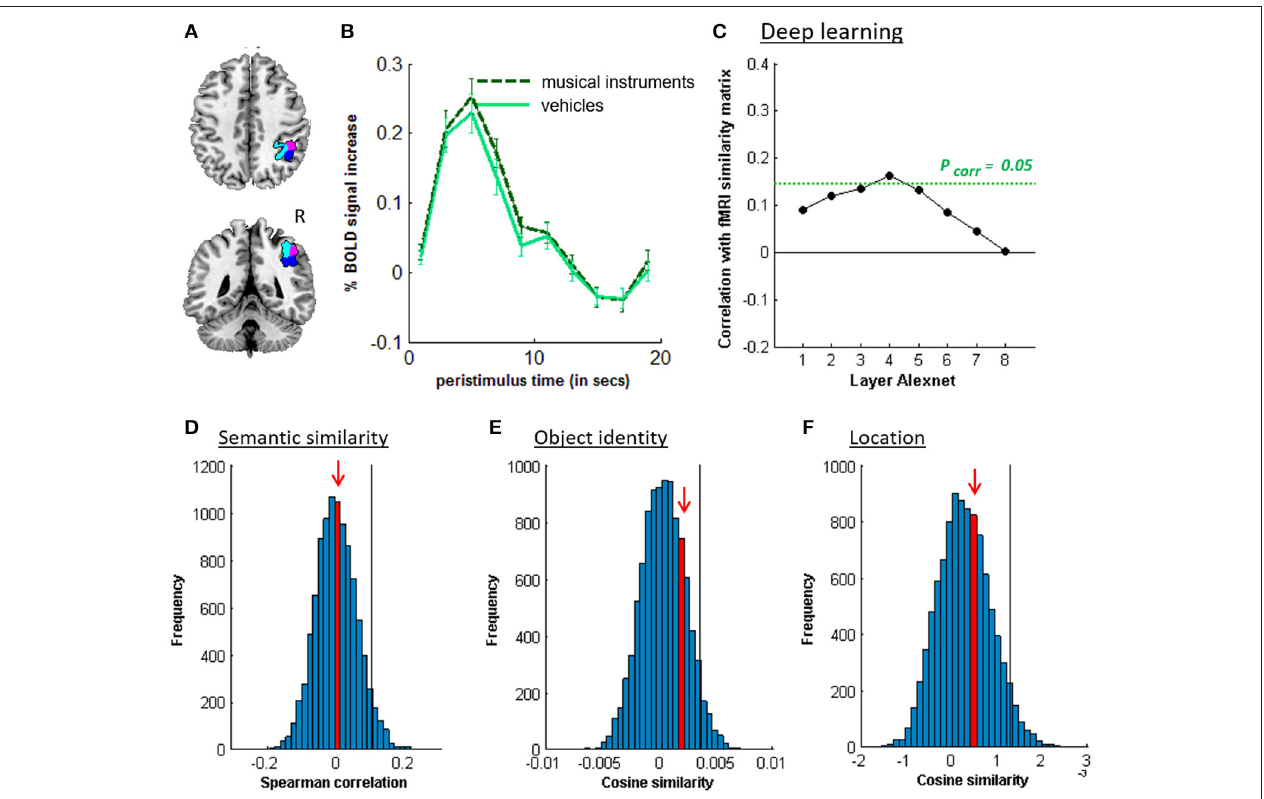
FIGURE 5 | MVPA effects in right middle IPS (hIP1-3). (A) Axial (z = 43) and coronal (y = − 46) slice depicting right middle IPS (hIP1, blue; hIP2, violet; hIP3, cyan). (B) Peristimulus response for musical instruments and vehicles. (C) Deep learning. Spearman correlation between the fMRI similarity matrix and the similarity matrices for the pictures for the eight layers of Alexnet. Statistical significance was evaluated by 10,000 random permutation labelings. The green dotted line corresponds to the statistical threshold corrected for the number of layers. (D) Probability distributions for the location-invariant semantic similarity effect. (E) Probability distributions for the location-invariant object identity effect. (F) Probability distributions for the object-invariant location effect. The red arrow indicates the true Spearman correlation/cosine similarity in the distribution of correlations/cosine similarities generated by 10,000 random permutations. X-axis: Spearman correlation averaged over the group of subjects. Y-axis: absolute frequency of a given average Spearman correlation value across all random permutation labelings. Black line: 95th percentile of the